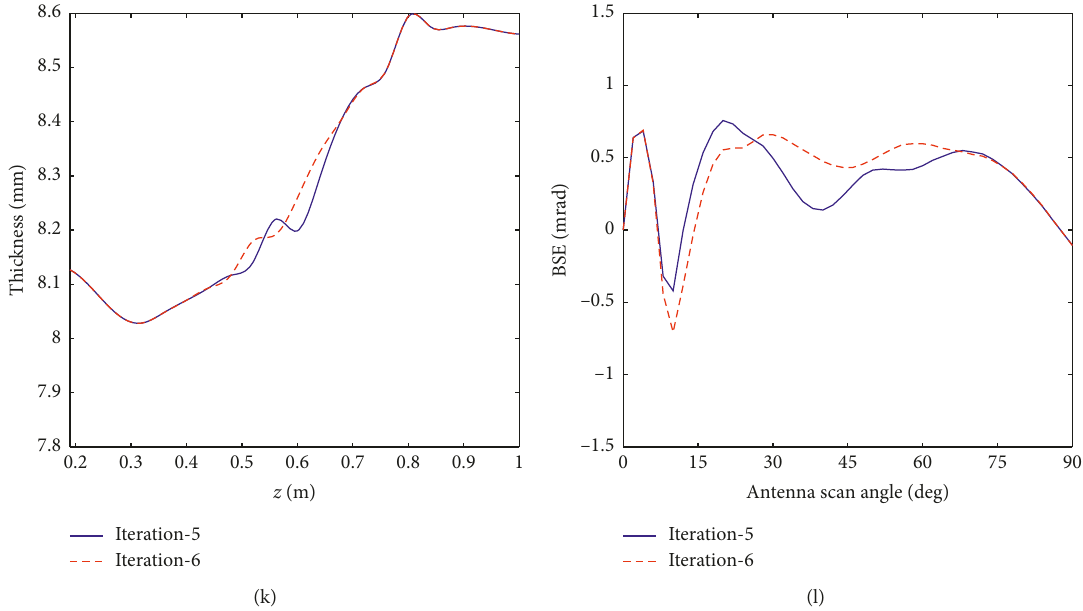
Figure 9: The thickness profile and BSE curve during the IPD correction process. (a, b) Iterations 0 and 1. (c, d) Iterations 1 and 2. (e, f) Iterations 2 and 3. (g, h) Iterations 3 and 4. (i, j) Iterations 4 and 5. (k, l) Iterations 5 and 6.